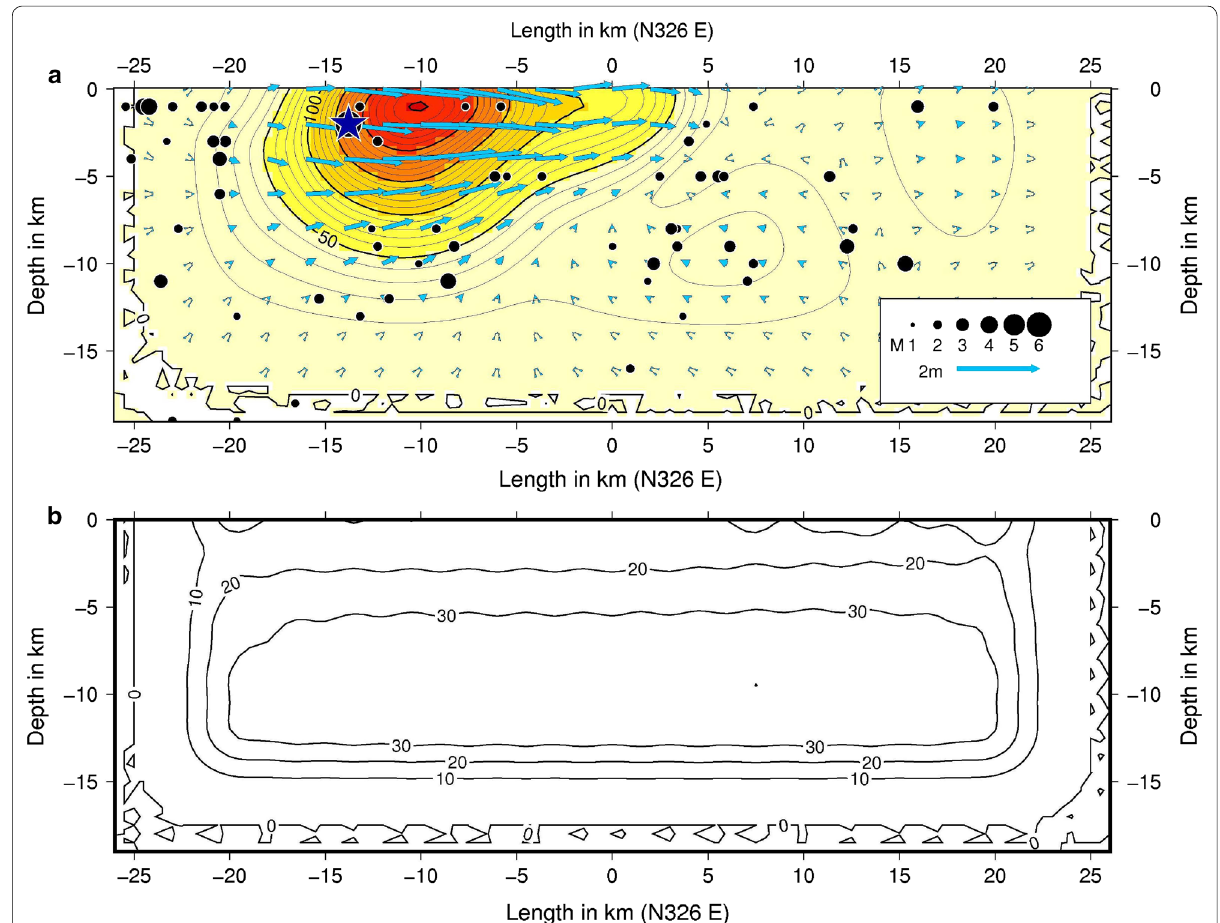
Fig. 12 a Estimated slip distribution for the 2017 Ormoc earthquake. Contours are drawn with 10 cm interval. Arrow direction shows the movement of the hanging wall (eastern side) with respect to the western side (right/up indicates left-lateral/reverse faulting). Black filled circles are the epicenters of aftershocks (6 July–31 December 2017) closer than 5 km from the fault surface, and star denotes the epicenter of the mainshock (PHIVOLCS), both projected on the fault plane. b Estimated standard deviation of the slip. Contours are drawn with 10 cm of